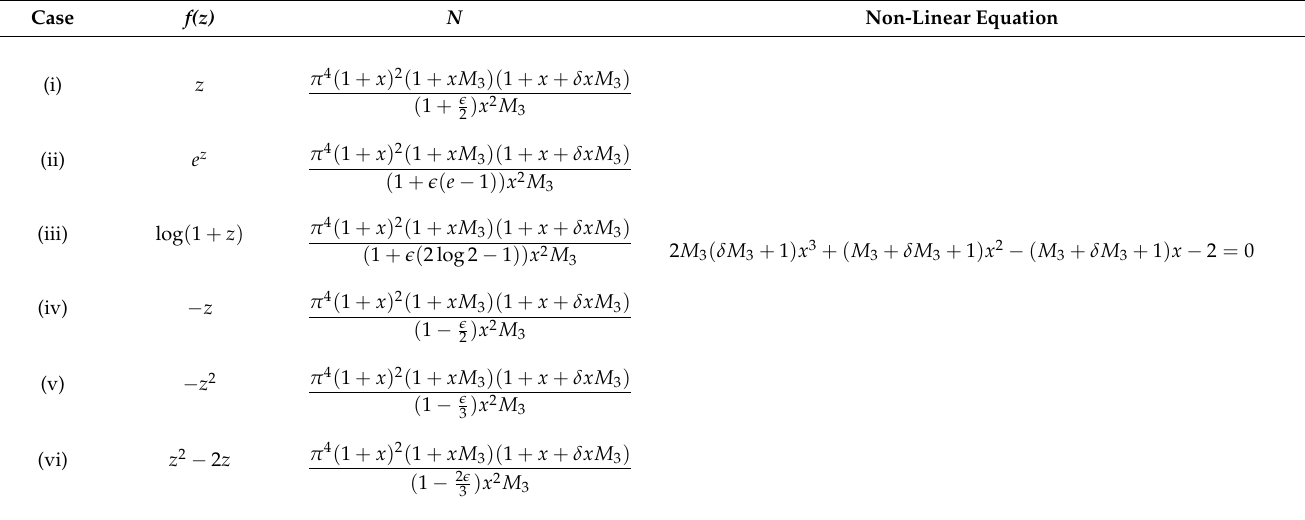
Table 3. The magnetic Rayleigh number and corresponding non-linear equations in variable x for different changeable gravity function f ( z ) .